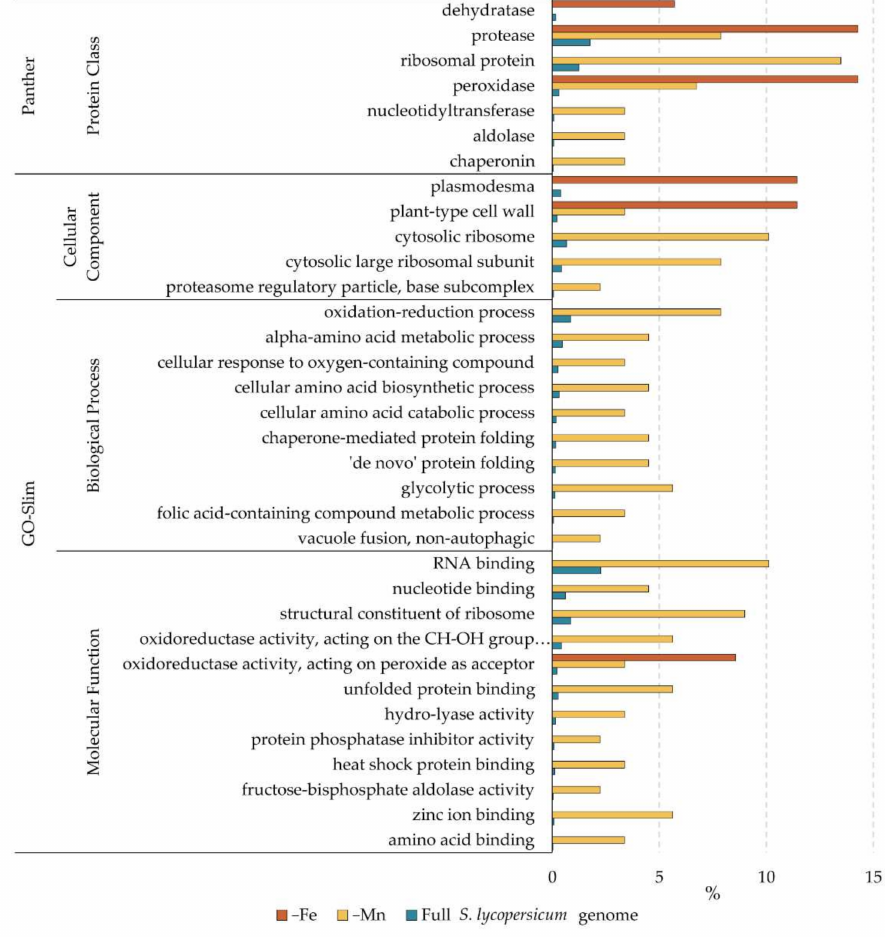
Figure 4. Enrichment in GO categories as a result of Fe and Mn deficiency. Bars represent the percentage of genes of a corresponding category in each dataset ( − Fe and − Mn) and in the whole S. lycopersicum